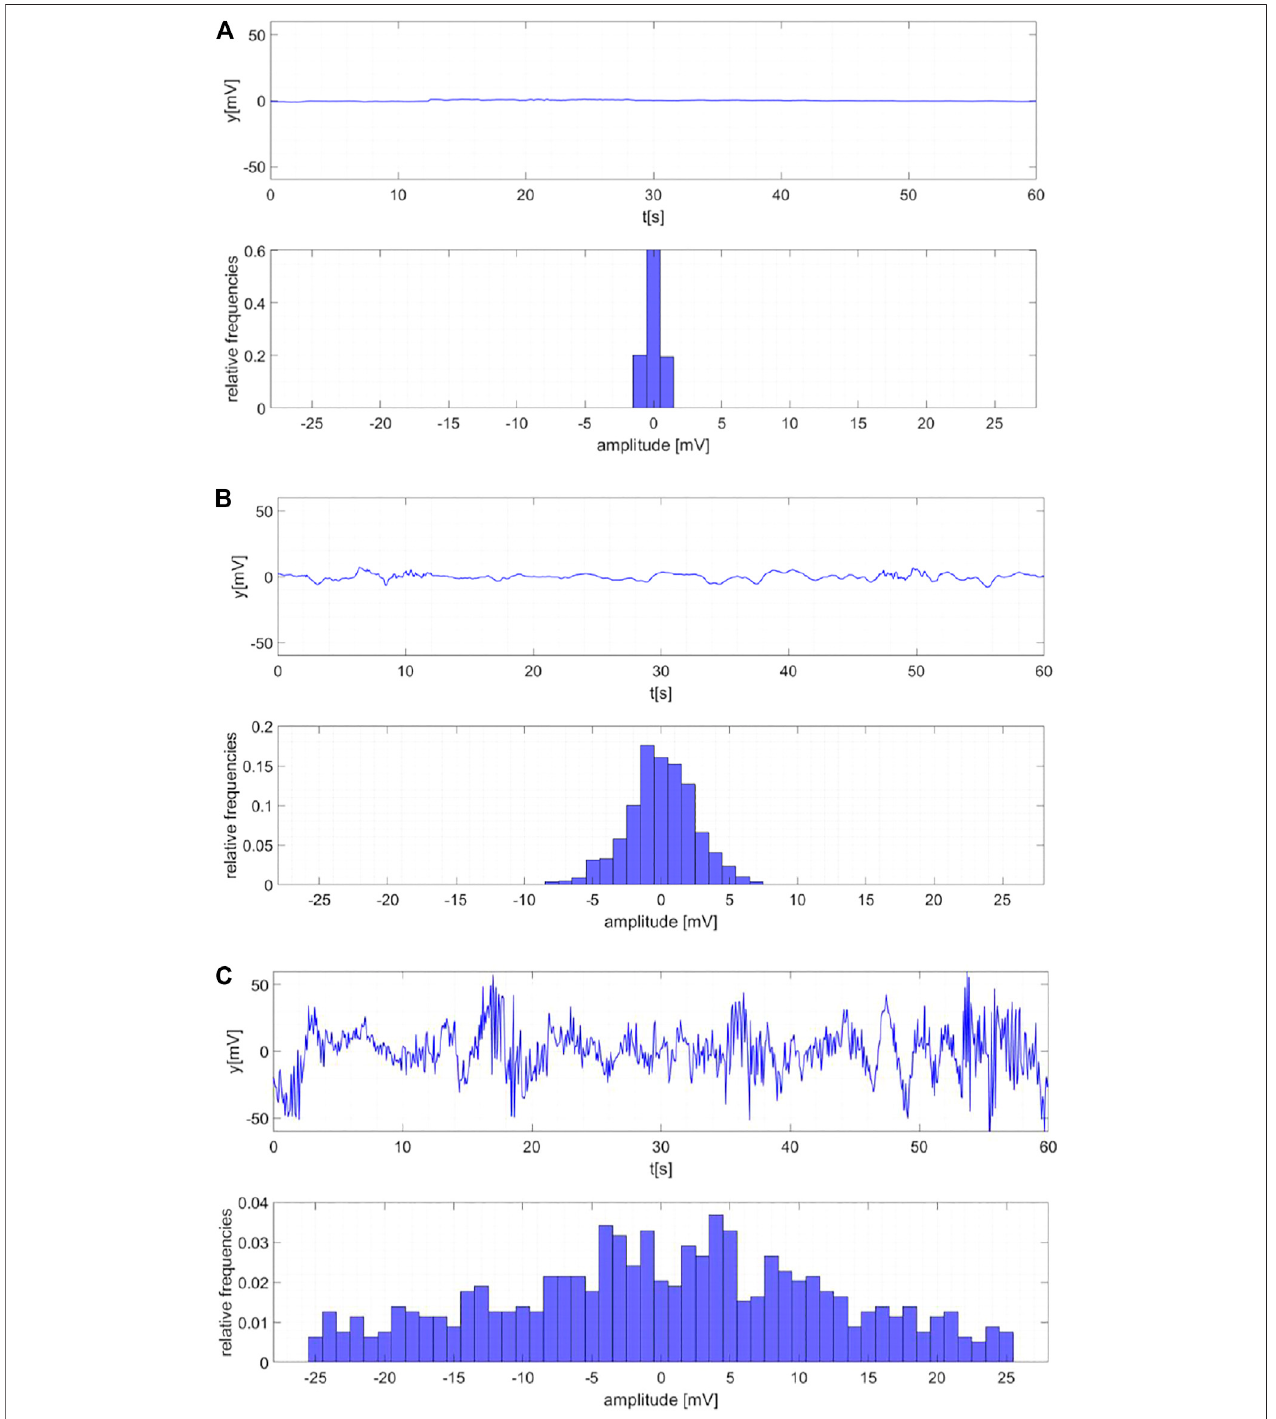
FIGURE 7 | Radar signals (top panels) and corresponding histograms of amplitudes (bottom panels). Empty scene (A) . Static subject 3 m far away from the radar (B) . Moving subject (C) .